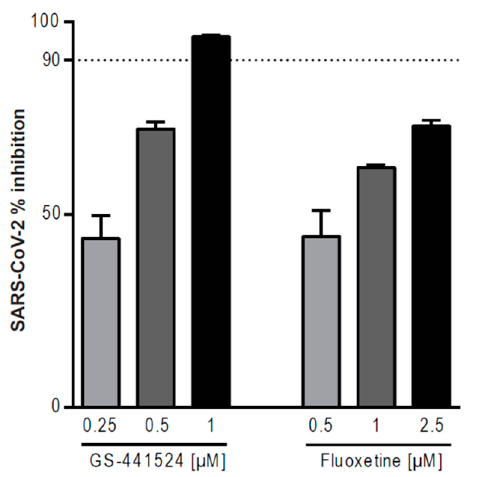
Figure 2. Antiviral activities of a single treatment against SARS-CoV-2 . Polarized Calu-3 cells were infected with SARS-CoV-2 and treated with the indicated GS-441524 or fluoxetine concentrations for 48 h. Bars represent mean percent inhibition ± SEM of infectious virus production, with mean virus titer produced in control cells (treated with the solvent DMSO) set to 100%; n = 5. Dotted line, 90% reduction in viral titer.